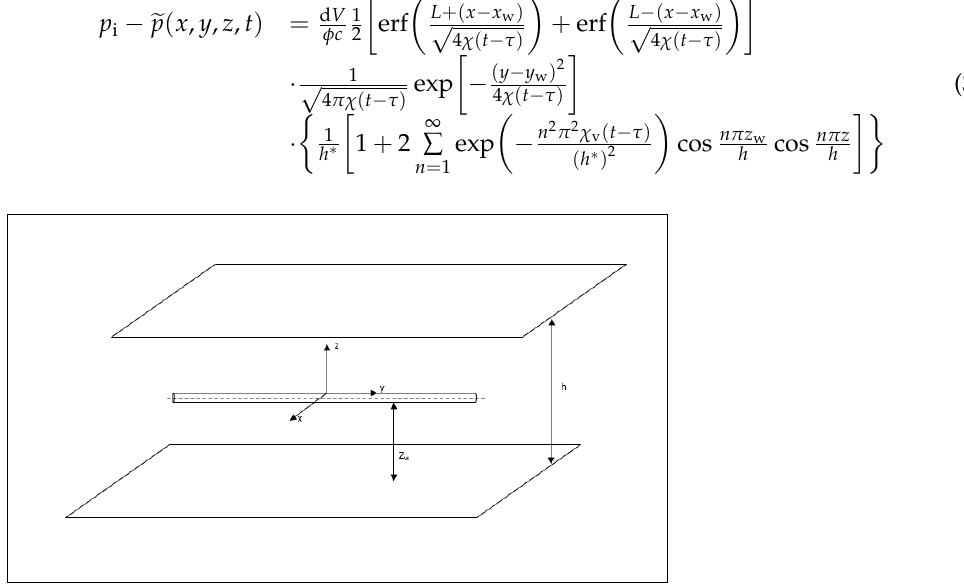
Figure 4. Horizontal well model diagram of infinite formation with upper and lower closed bound ‐ ary.